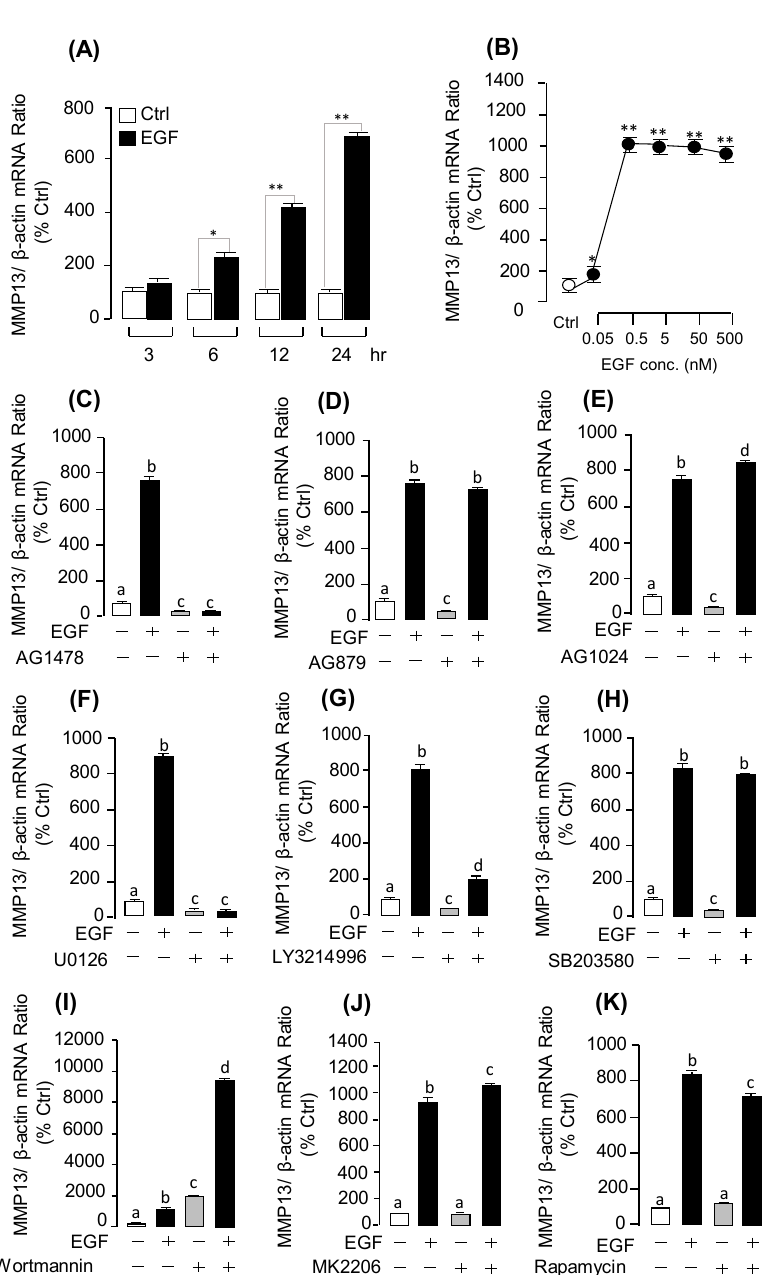
Figure 5. EGF induced MMP13 mRNA expression and receptor specificity and signal transduction mechanism in grass carp pituitary cells. ( A ) Pituitary cells were treated with EGF (0.5 µ M) in a time dependent manner. ( B ) dose-dependent manner of EGF (0.05–500 nM) induced MMP13 mRNA expression, respectively. ( C – E ) E ff ects of ErbB1 antagonist AG1478 (10 µ M), ErbB2 antagonist AG879 (10 µ M),andIGFreceptorantagonistAG1024(10 µ M)on MMP13 mRNAexpressionfor24h, respectively. ( F – H ) Signal transduction of EGF-induced MMP13 mRNA expression in grass carp pituitary cells. Co-treatment of 24 h with the MEK blocker U0126 (10 µ M), ERK1 / 2 inhibitor LY3214996 (10 µ M), or p38MAPK inhibitor SB203580(10 µ M) induced MMP13 mRNA expression was examined in grass carp pituitary cells, respectively. ( I – K ) Co-treatment of 24 h with the PI 3 K inhibitor Wortmannin (10 µ M), AKT inhibitor MK2206 (10 µ M), and mTOR inhibitor Rapamycin (10 µ M) induced MMP13 mRNA expression was examined, respectively. After drug treatment, total RNA was isolated for real-time PCR of MMP13 mRNA expression. The di ff erences between groups were considered as significant at p < 0.05 (“*”) or highly significant at p < 0.01 (“**”). The groups denoted by di ff erent letters represent a significant di ff erence at p <